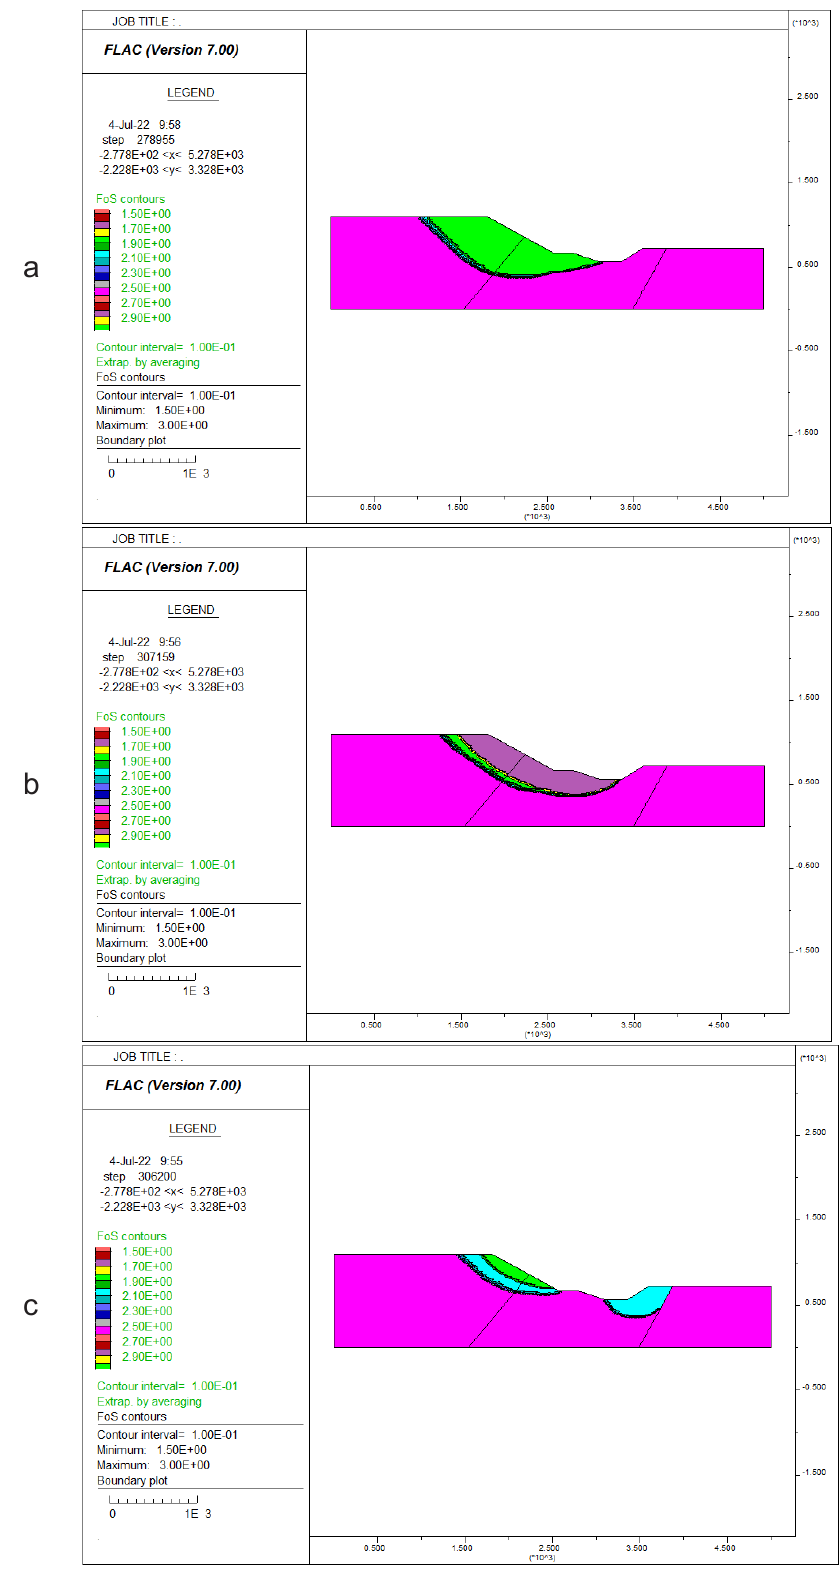
Figure 9: FoS values for defferent scenarios of UG operation by 2025: (a) scenario I, (b) scenario II, (c) scenario